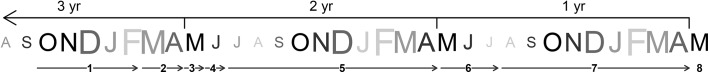
A life history timeline for sexual recruits censused via aerial photography.Monthly abbreviations are positively scaled to mean relative wave energy (RWE; J/m) and color graded to mean bottom-water temperature (proportion of days within optimal range). All means were calculated using the appropriate offset relative to spring census; annual marks describe the direction of offset. Bottom arrows denote significant life history stages during the inference period for sexual recruitment: i.e., (1) floral induction, (2) flower development, (3) anthesis, (4) embryo development and seed dehiscence, (5) seed bank, (6) seedling emergence, (7) patch development, and (8) photographic census.